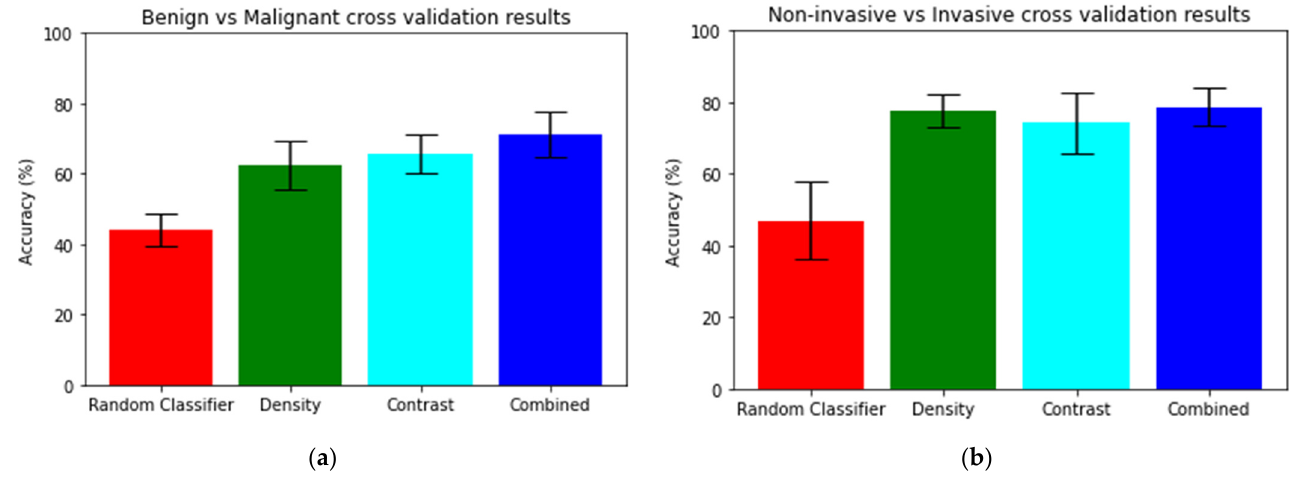
Figure 5. Accuracies of ( a ) malignancy vs. benignity classification and ( b ) invasive vs. non-invasive malignancy classification using radial histogram PLDA.